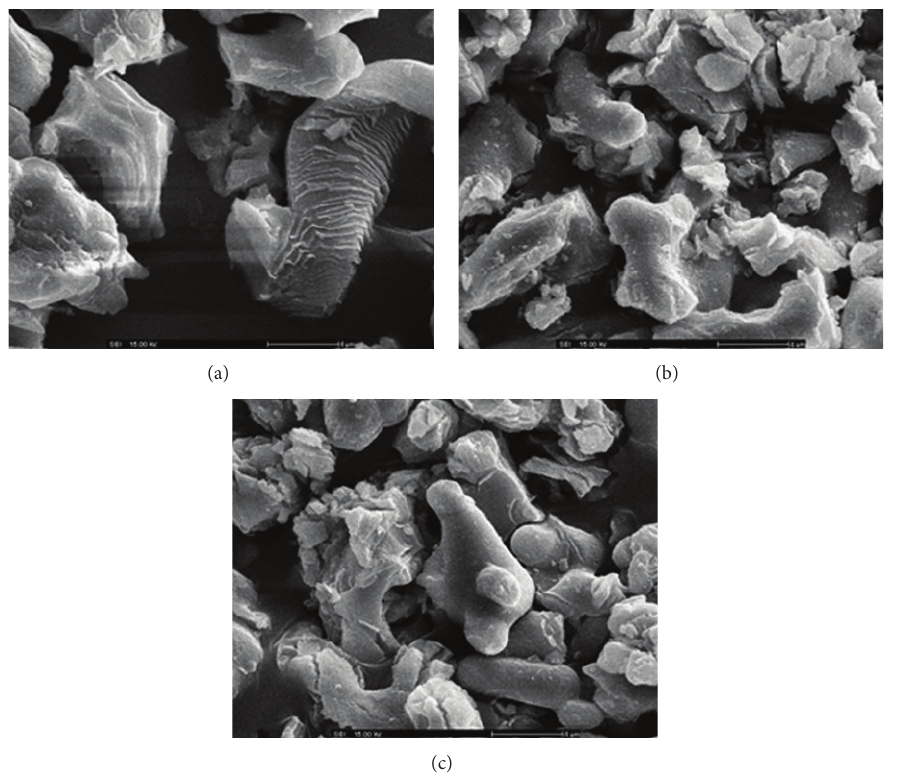
Figure 4: SEM images of (a) mussel shell, (b) cockle shell, and (c) scallop shell calcined at 1,000 ∘ C.